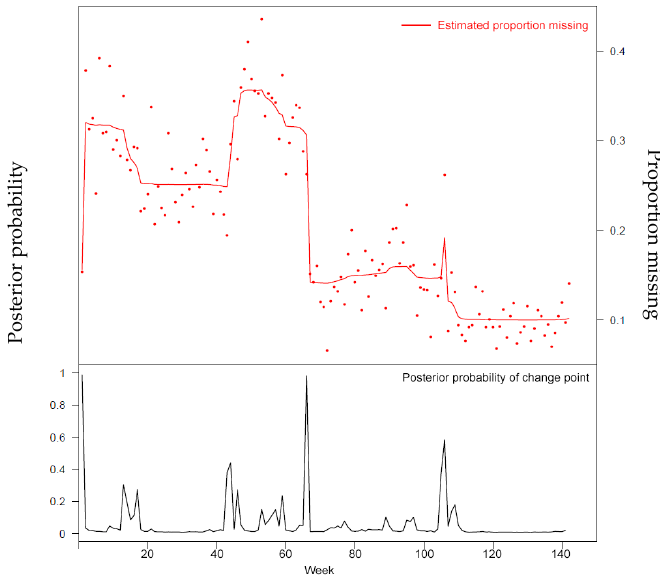
Figure 1. Missing value rates for ethnicity field, SWIMMS database.